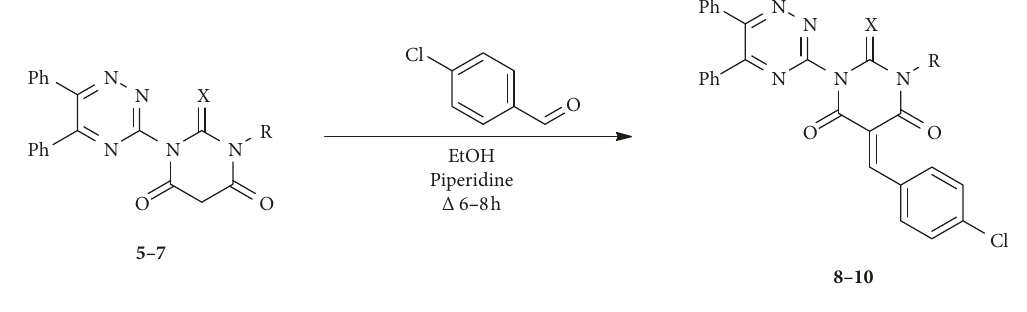
Scheme 2: Synthesis of compounds 8 – 10 .